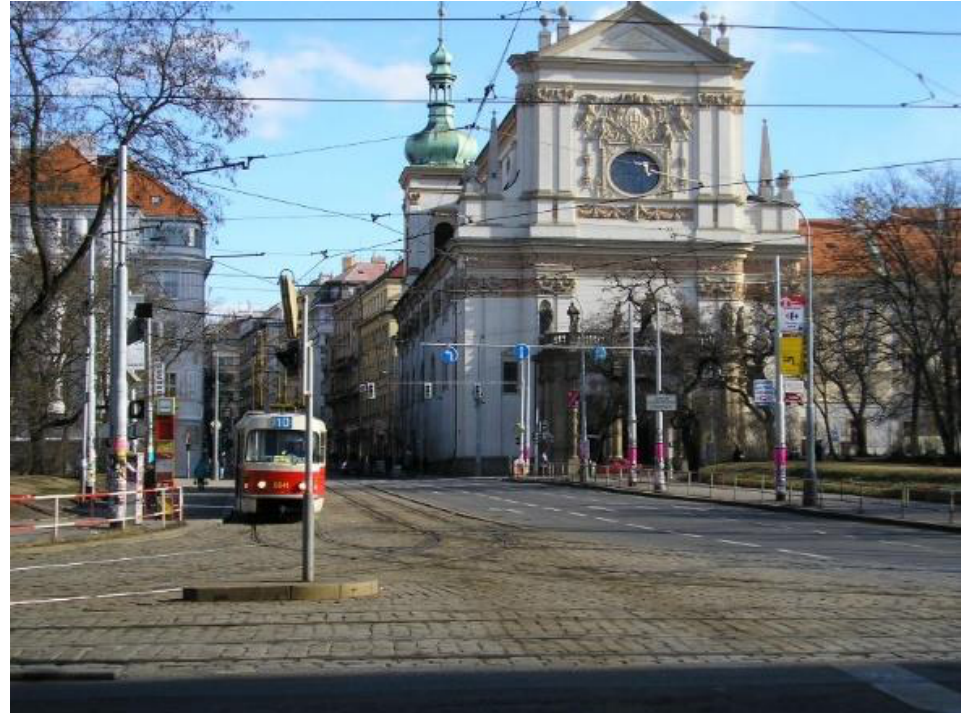
Figure 2. Center of the Charles Square with St. Ignac Church. Remains of the Holy Body Chapel were situated under tram rails and tram stop.